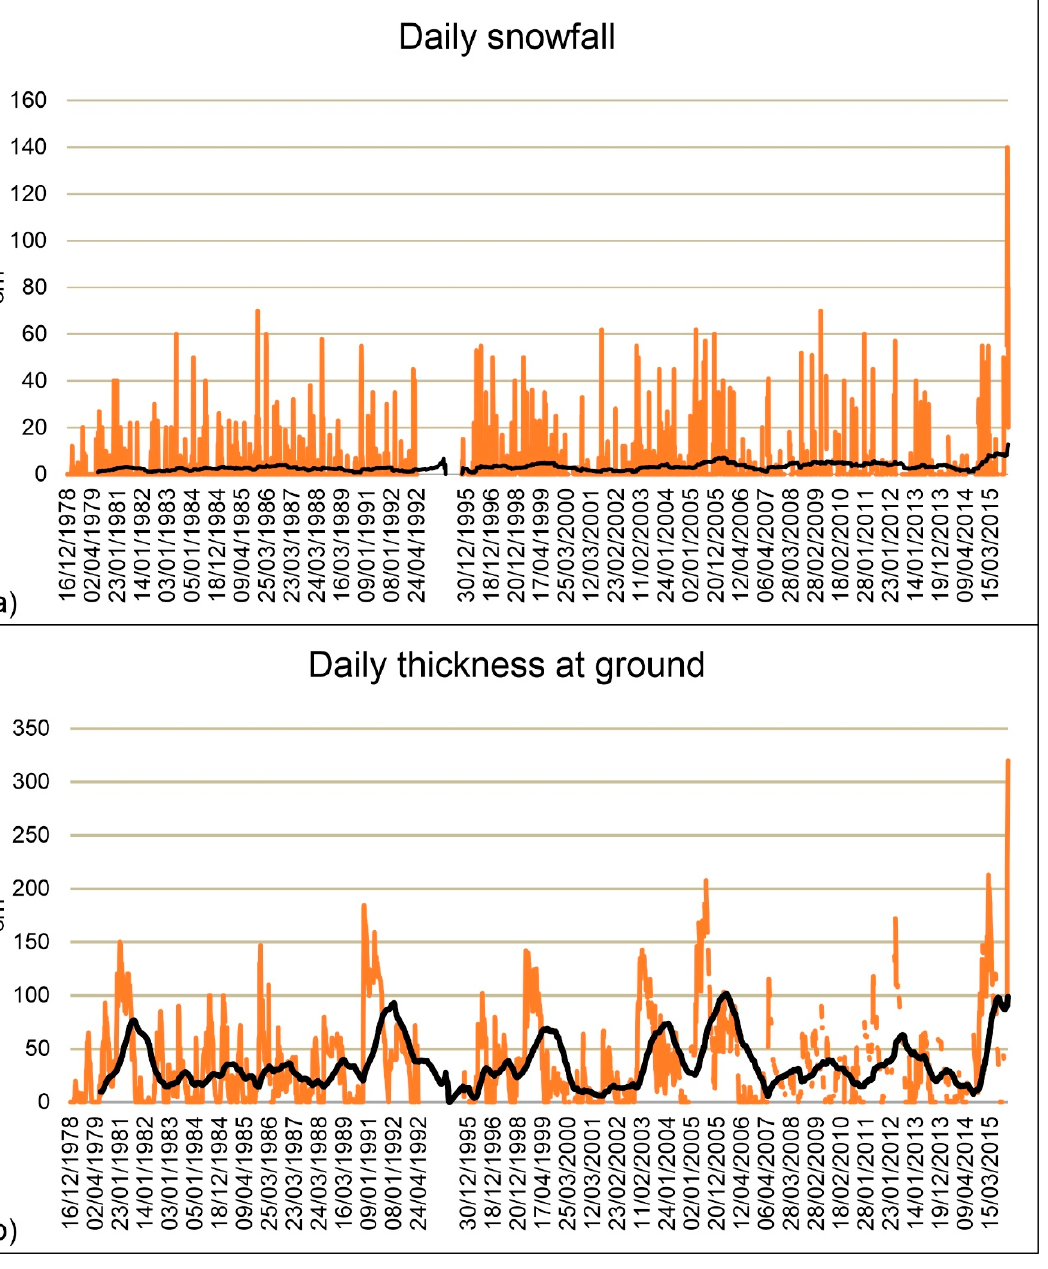
Figure 10. Daily snowfall ( a ) and snow cover thickness ( b ) at the Prati di Tivo gauge (1450 m a.s.l.).